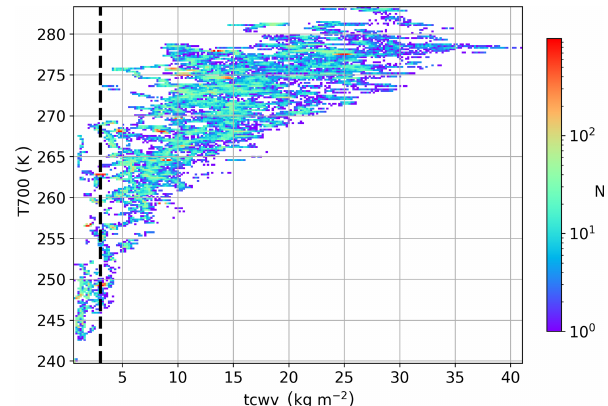
≡ OCO-2 ( (cid:49)X CO 2 2 Figure 23. Midtropospheric temperature (T700 ≡ temperature at 700hPa) as a function of total column water vapor (tcwv) for all coincident retrievals without QC